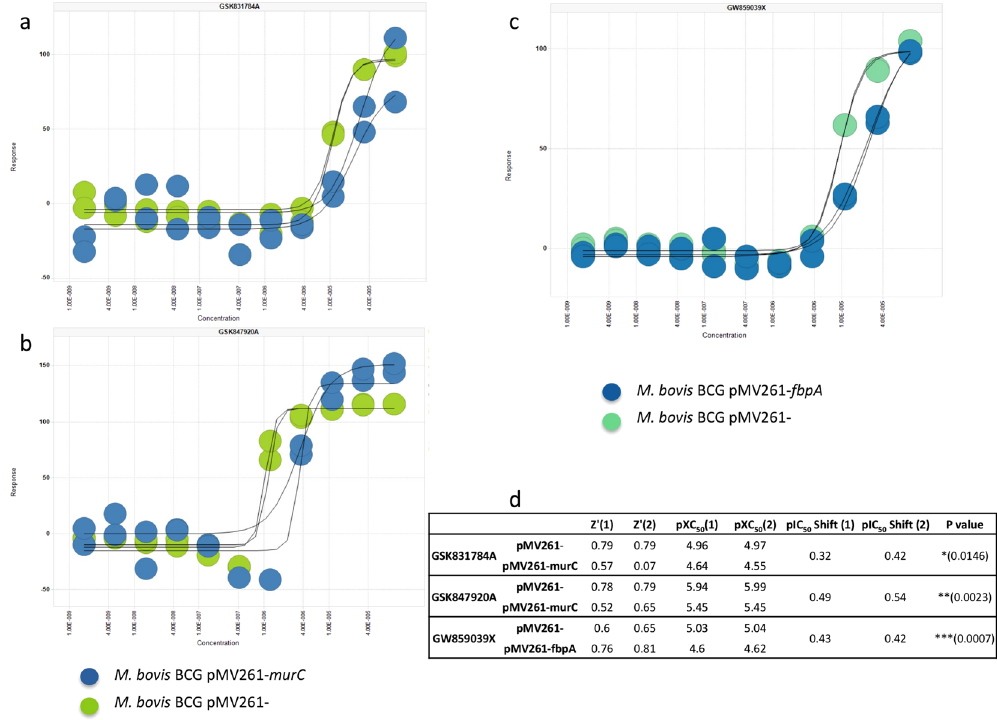
Figure 5. Identification of molecular targets of compounds from GSK TB-set. The shift in cell viability against a dose response of ( a ) GSK831784A and ( b ) GSK847920A upon over expression of MurC. Over expression of FbpA led to a shift in dose response to ( c ) GW859039X. ( d ) A tabulated summary of pXC50 shift values of each strain against the respective